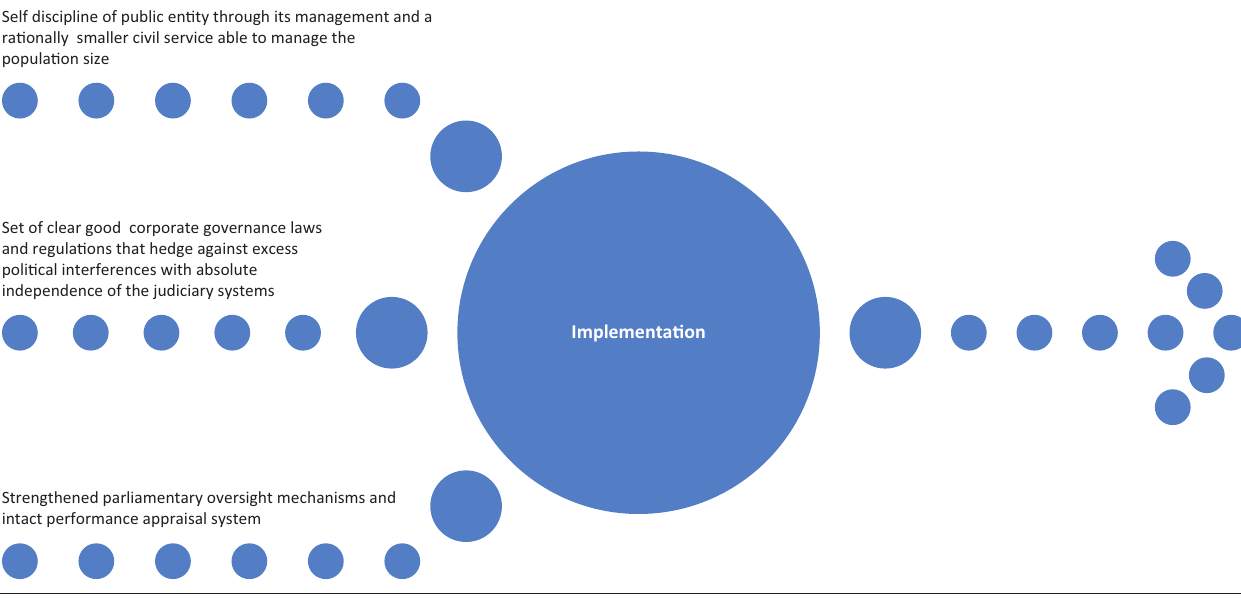
FIGURE 3: Public sector good governance implementation process